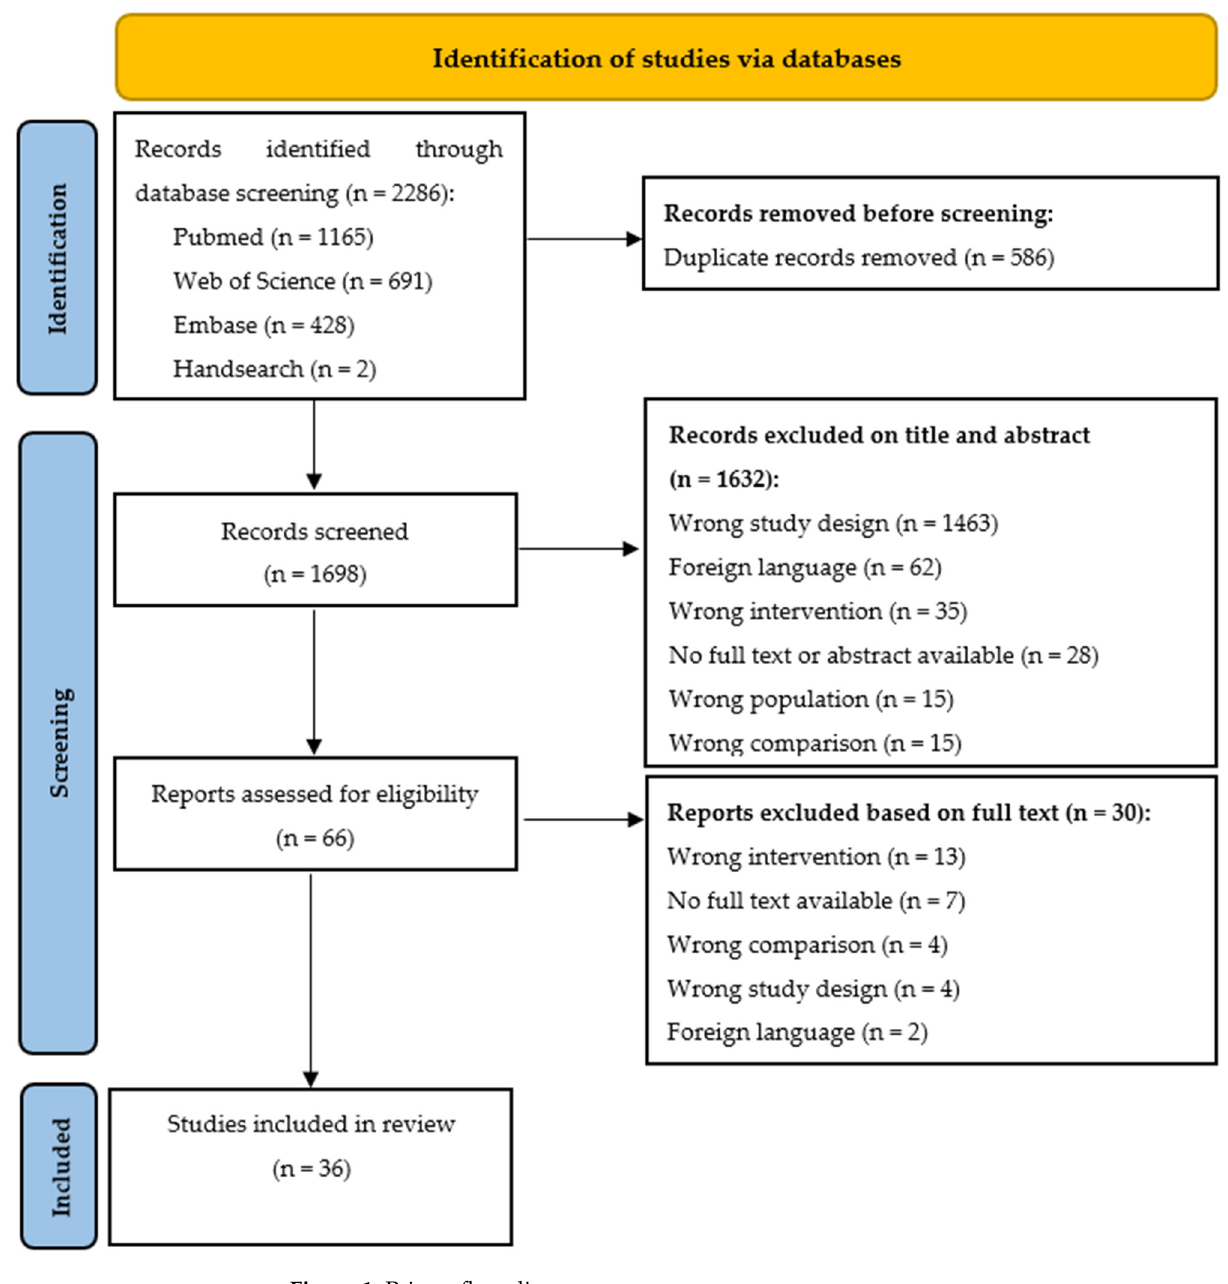
Figure 1. Prisma flow